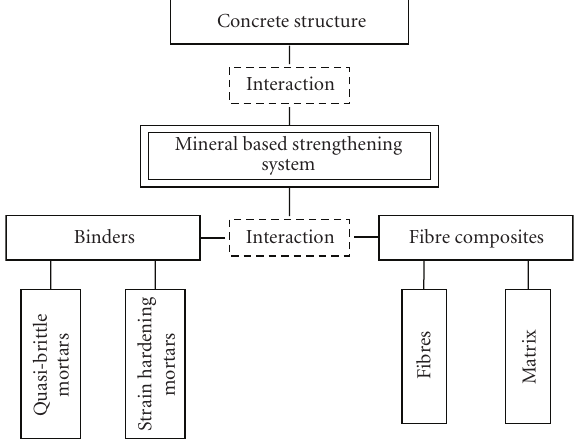
Figure 2: Overview of the constituents and possible interaction in mineral-based strengthening